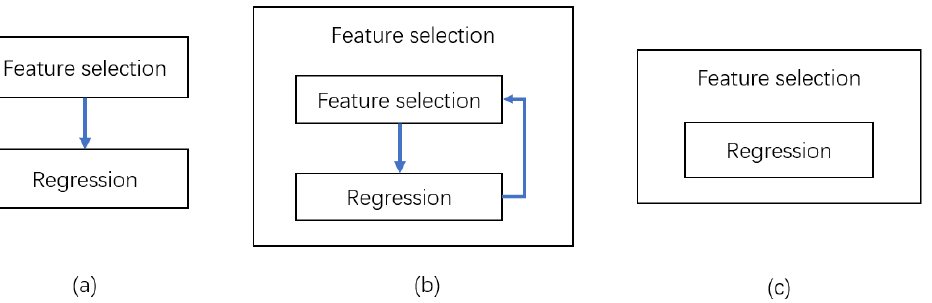
Figure 2. Three different feature selection schematics. ( a ) Filter feature selection; ( b ) wrapped feature selection; ( c ) embedded feature selection.